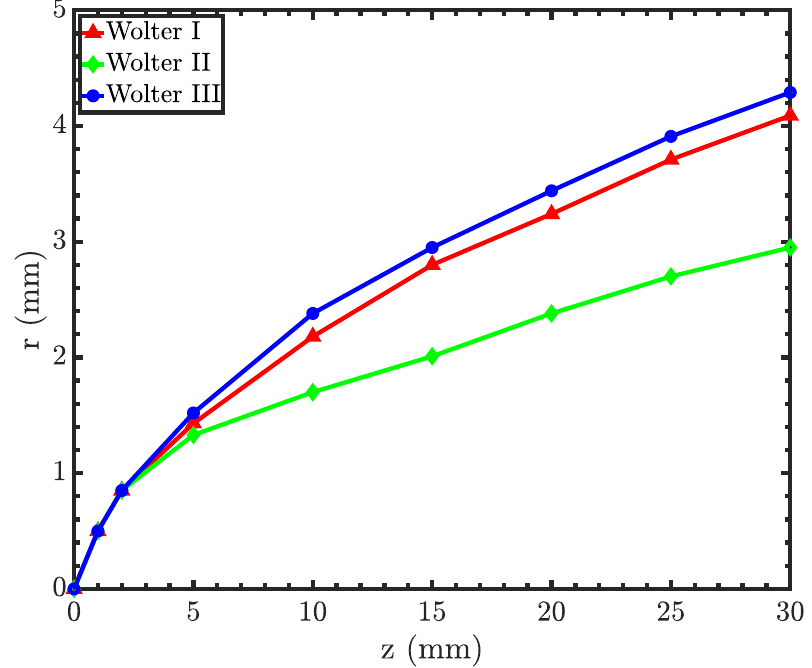
Figure 14. Field curvature of the three optical designs. The r-axis is the radial distance from the optical axis, and the z-axis is the distance from the focal